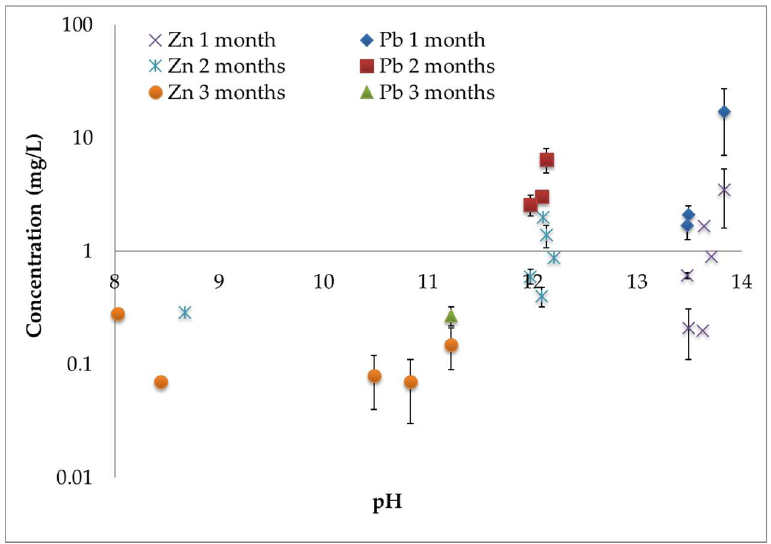
Figure 2. Concentration values of Pb and Zn in the leaching solution of stabilized samples (involving both procedures a) and b)) during the first three months versus the pH.